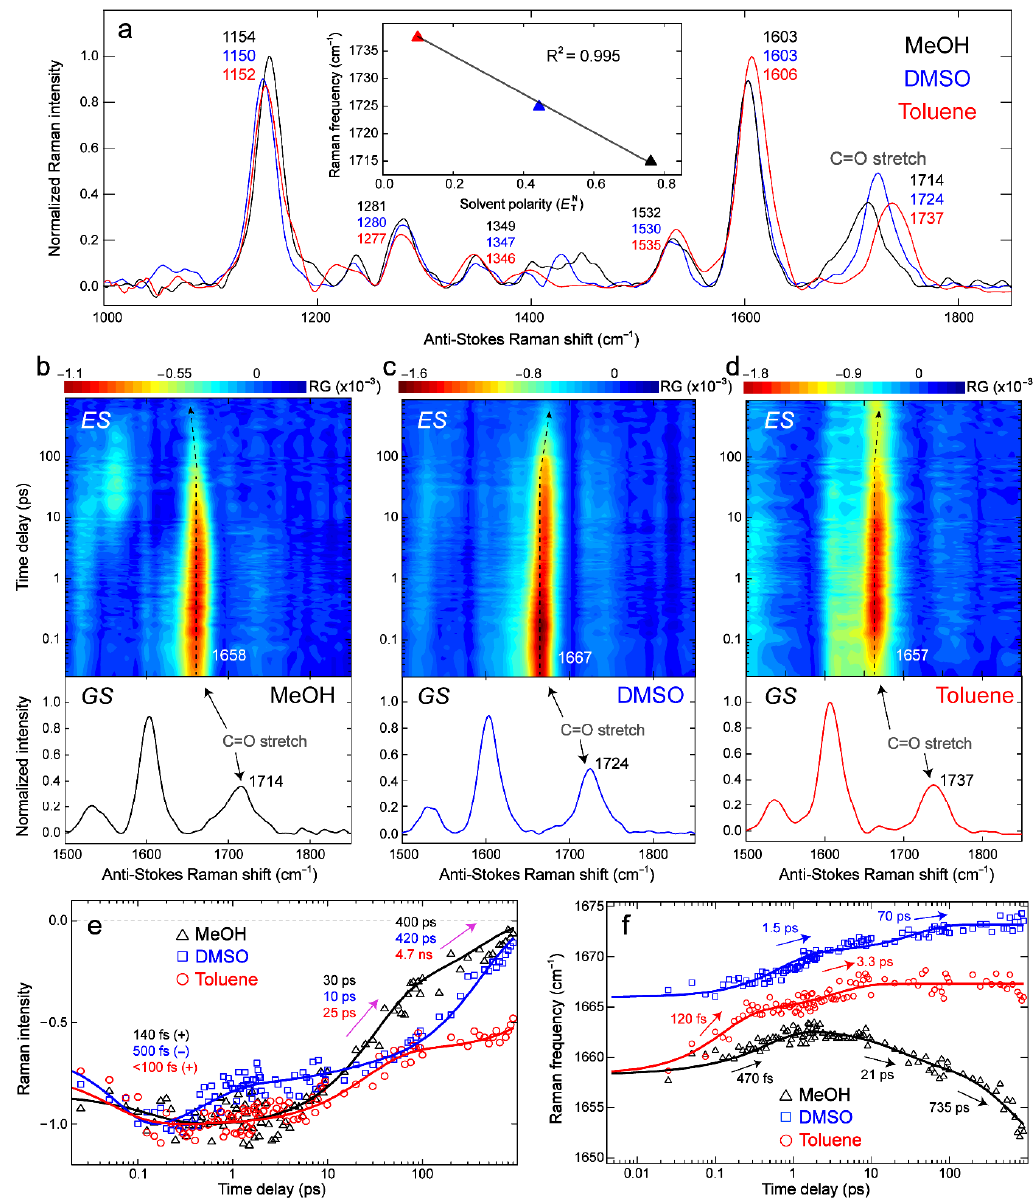
Figure 4. Vibrational signatures delineate the non-equilibrium structural dynamics of photoexcited chromophore C481 in various solvents. ( a ) Ground-state FSRS of C481 in MeOH (black), DMSO (blue), and Toluene (red) with a linear correlation between the C=O stretching mode frequency and solvent polarity displayed in the inset. Pronounced vibrational mode frequencies are listed by the respective peaks (color-coded with three solvents, see Table S4 for mode assignments). Semilogarithmic contour plots for the excited state (ES, top; after 400 nm excitation) and the separately collected ground state (GS, bottom) FSRS spectra on the anti-Stokes side for C481 in ( b ) MeOH, ( c ) DMSO, and ( d ) Toluene. The C=O stretch marker band frequencies and shift trend from GS to ES are highlighted by solid and dashed arrows. Excited-state Raman ( e ) intensity dynamics and ( f ) peak frequency shift of C481 in MeOH (black triangles), DMSO (blue squares), and Toluene (red circles) are overlaid with the least-squares multiexponential fits (color-coded solid lines). The retrieved time constants are denoted by the respective arrows. In panel e , the initial time constant has a (+) or ( − ) sign to denote an intensity rise or decay component, and the negative intensity data points are scaled to normalize the associated least-squares fits (color-coded solid traces) at the peak magnitude region for a better comparison of the fit quality and trend of C481 in three